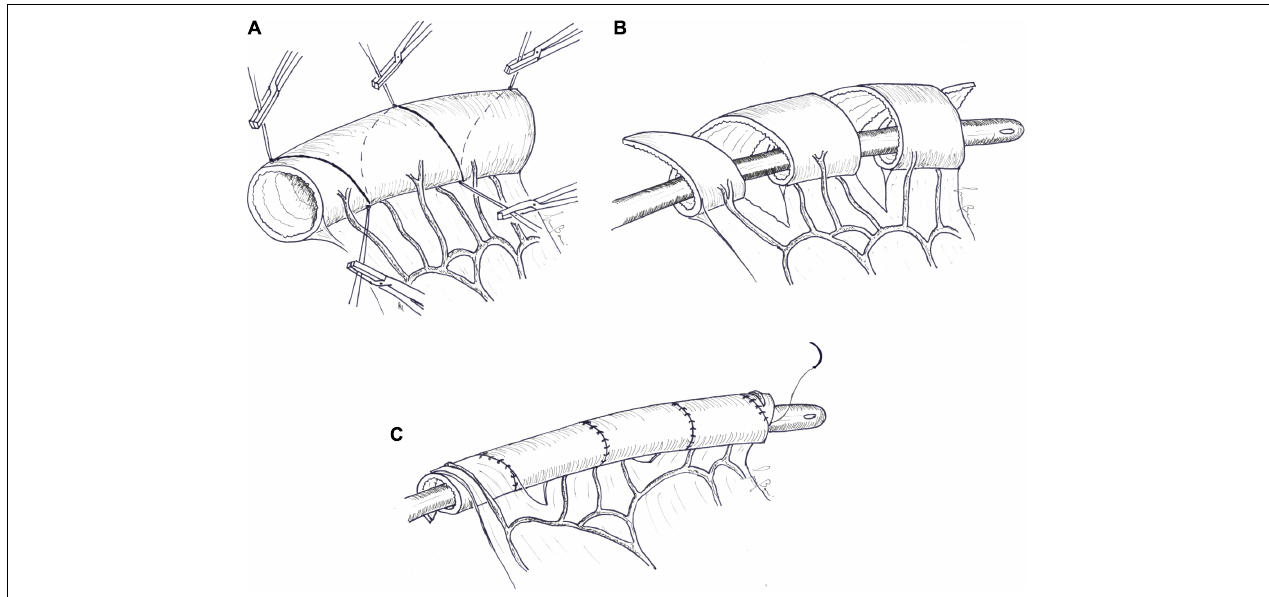
FIGURE 6 | Spiral intestinal lengthening and tailoring (SILT). (A) Spiral incision lines are drawn at 45–60 ◦ . Stay sutures are placed where the spiral lines met on the antimesenteric and mesenteric borders. (B) The bowel is then cut into a spiral shape by bipolar diathermy following the previously drawn line. Once the spiral incision reaches the mesenteric border, the mesentery is also incised perpendicular to the longitudinal axis. The incised bowel is stretched longitudinally over an intraluminal silicon catheter. (C) Contiguous bowel edges are then sutured with an absorbable continuous introverting